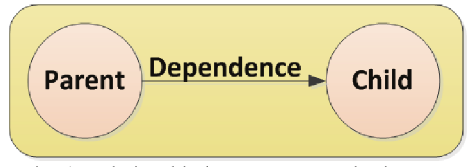
Fig. 4. Relationship between two nodes in a BN